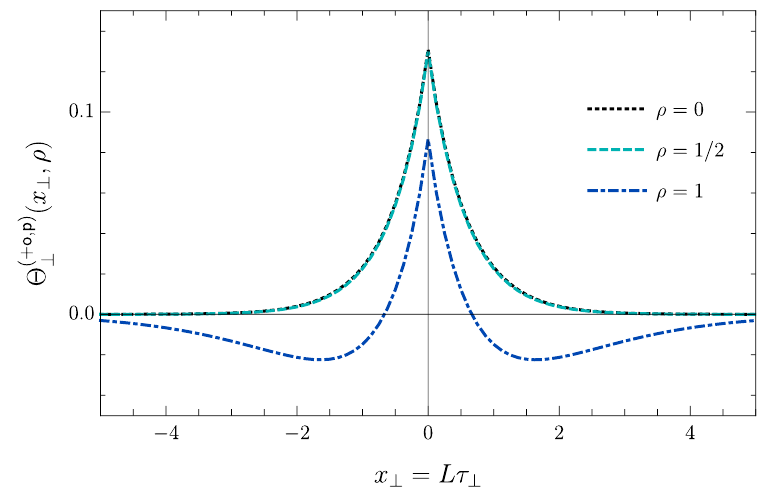
(+ o , p ) ( x ρ ) for different values of the aspect ratio ⊥ , ⊥